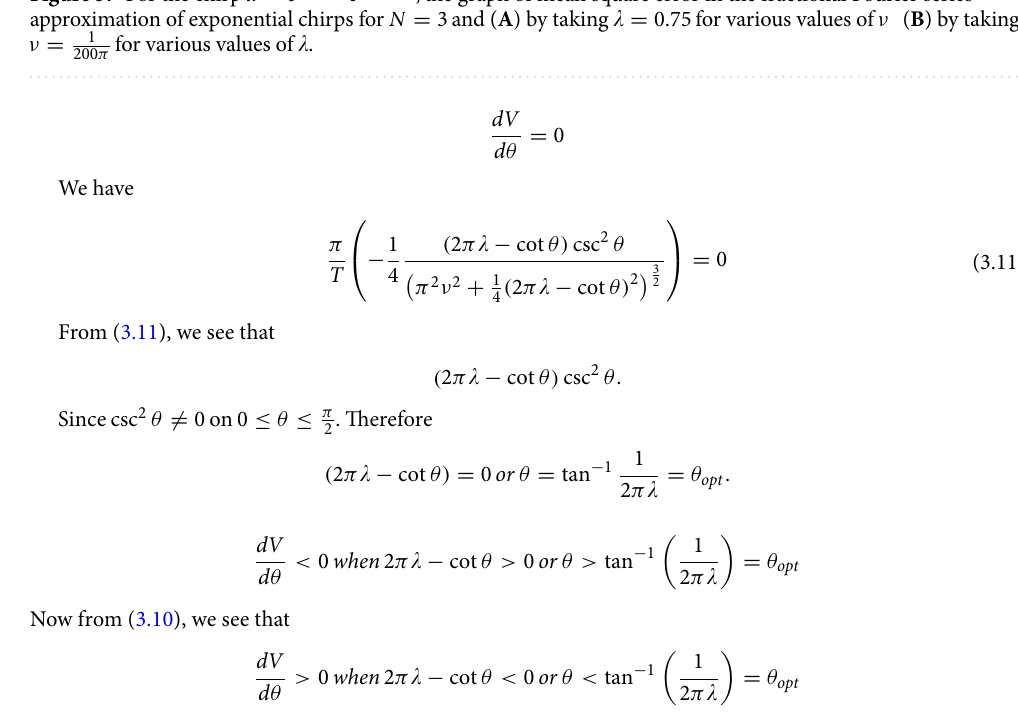
0.75 for various values of ν ( B ) by taking =